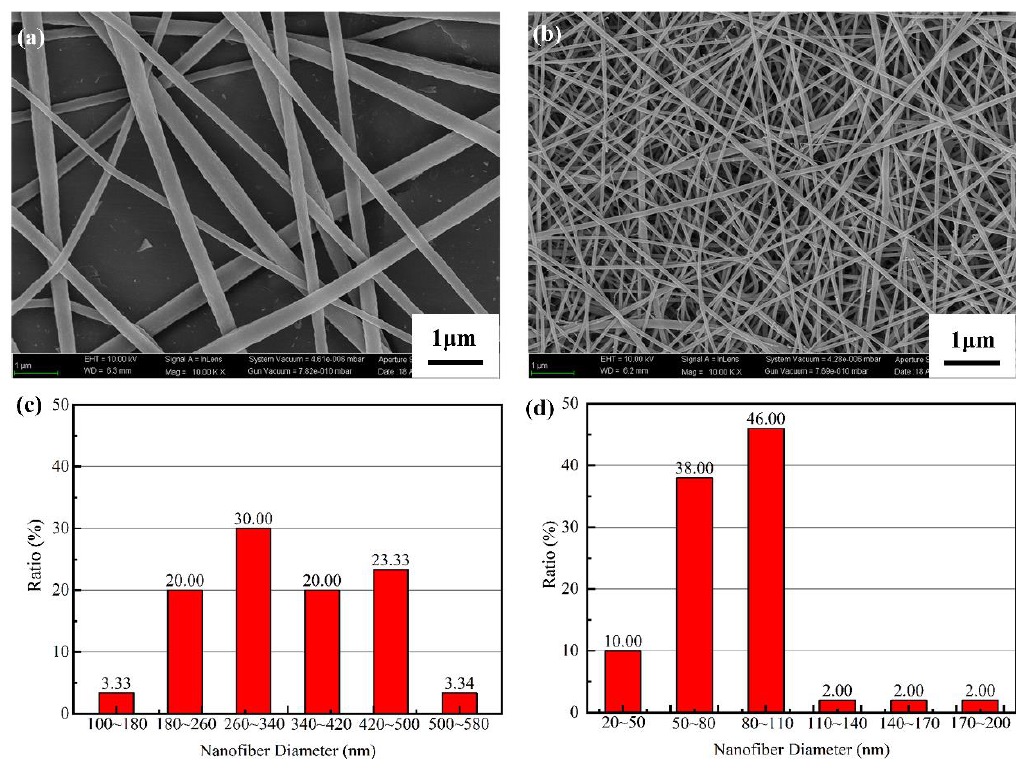
Figure 3. Nanofiber membranes. ( a ) scanning electron microscope (SEM) images of polyamide-6 (PA6) nanofibers; ( b ) SEM images of polyvinyl chloride (PVC) nanofibers, where magnification was 10,000 × ; ( c ) diameter distribution of the PA6 nanofibers; ( d ) diameter distribution of the PVC nanofibers.